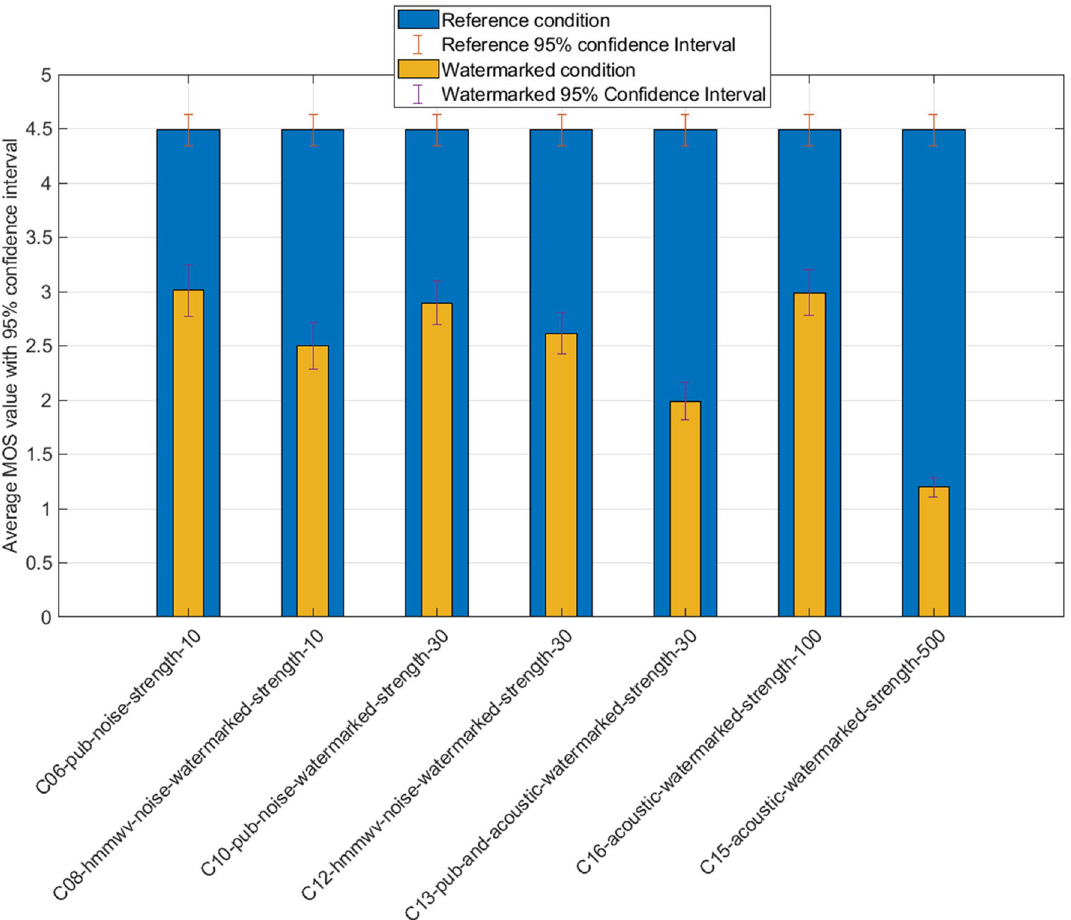
Figure 4. Results of reference studio condition with noise and increasing watermarking